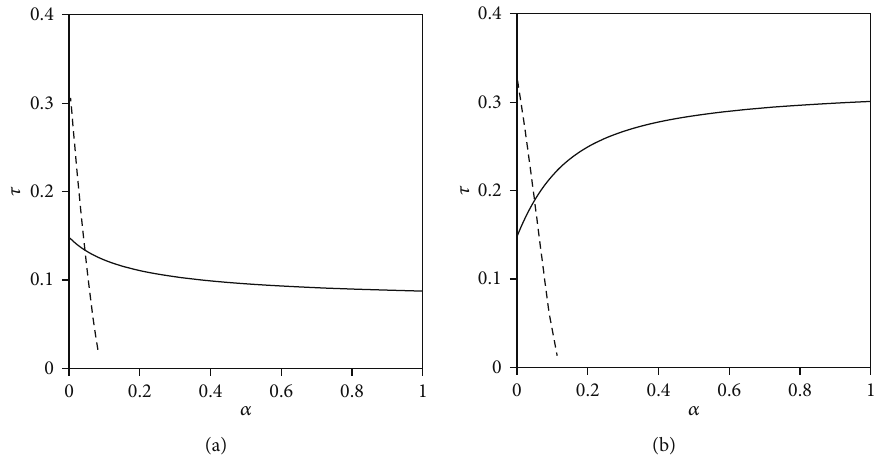
Figure 3: Bifurcation diagrams of a standing pulse. The data are obtained by the singular perturbation method in the limit ε ⟶ 0 : Solid and dashed curves represent τ